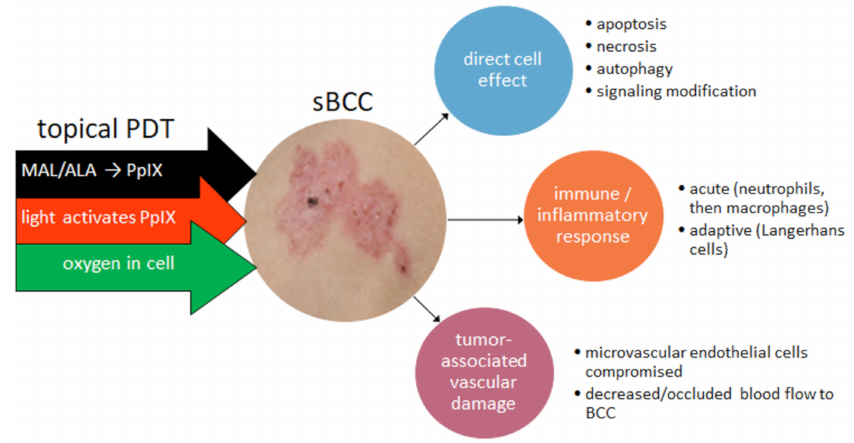
Figure 3. E ff ects of topical photodynamic therapy on superficial BCC (sBCC) (MAL, methyl aminolevulinate; ALA, aminolevulinic acid; PpIX, protoporphyrin IX; and BCC, basal cell